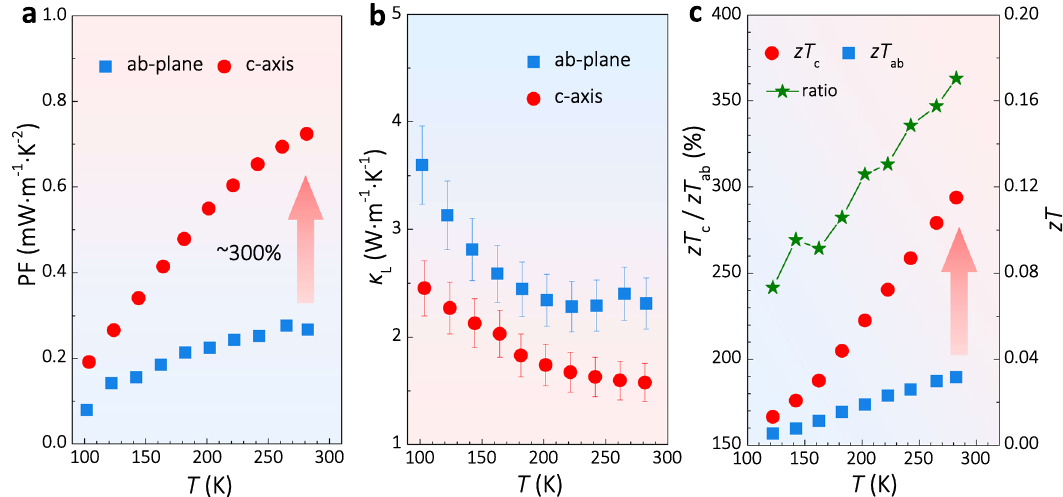
Fig. 4 The TE properties of single-crystal Mg 3 Sb 2 . Temperature dependences of a PF; b κ L ; c zT ; and zT ratio along c-axis and ab-plane for the Ag-doped Mg 3 Sb 2 single